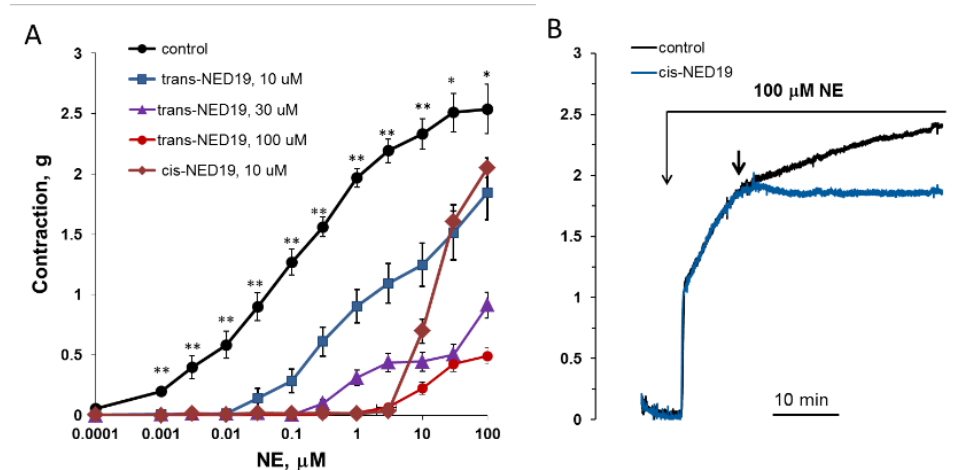
Figure 9. Contraction of rat aorta rings in response to increasing NE concentrations in the absence and presence of 10, 30, and 100 µ M trans -NED 19 or 10 µ M cis -NED 19 ( A ), and the influence of 30 µ M cis -NED 19 on aorta preconstricted with 100 µ M NE ( B ). Short arrow indicates addition of cis -NED 19 or vehicle. Each point is a mean of 8–12 independent measurements (8–12 rats) + SEM (* p < 0.05, ** p < 0.01 when compared with the contractions in the presence of cis - or trans -NED19). In panel B, the representative results from one of four experiments are presented.